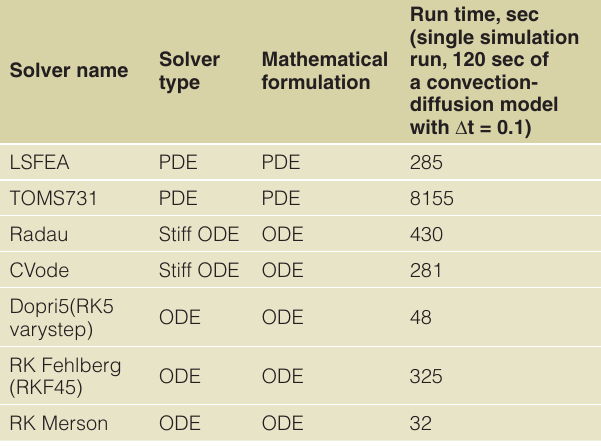
Table 4. JSim’s ODE & PDE